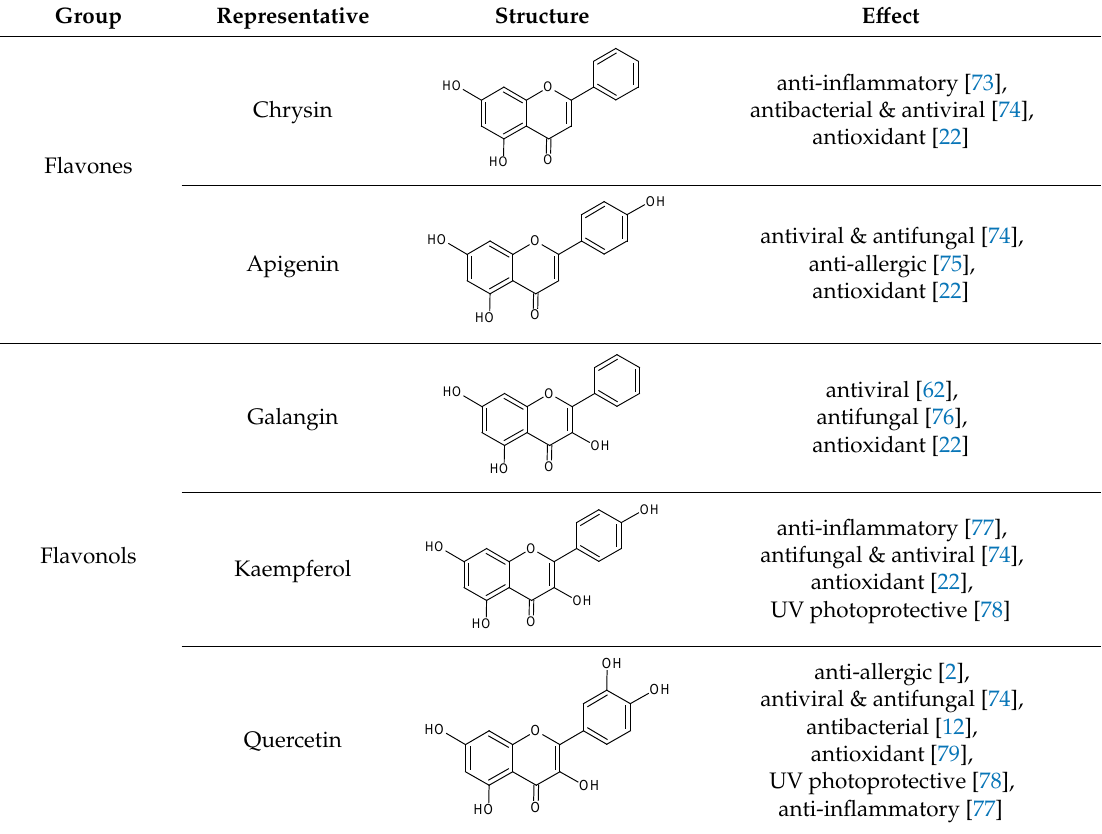
Table 1. Main e ff ects of selected flavonoids and phenolic acids on skin. Table 1. Main effects of selected flavonoids and phenolic acids on skin. Table 1. Main effects of selected flavonoids and phenolic acids on skin. Table 1. Main effects of selected flavonoids and phenolic acids on skin. Table 1. Main effects of selected flavonoids and phenolic acids on skin. Table 1. Main effects of selected flavonoids and phenolic acids on Group